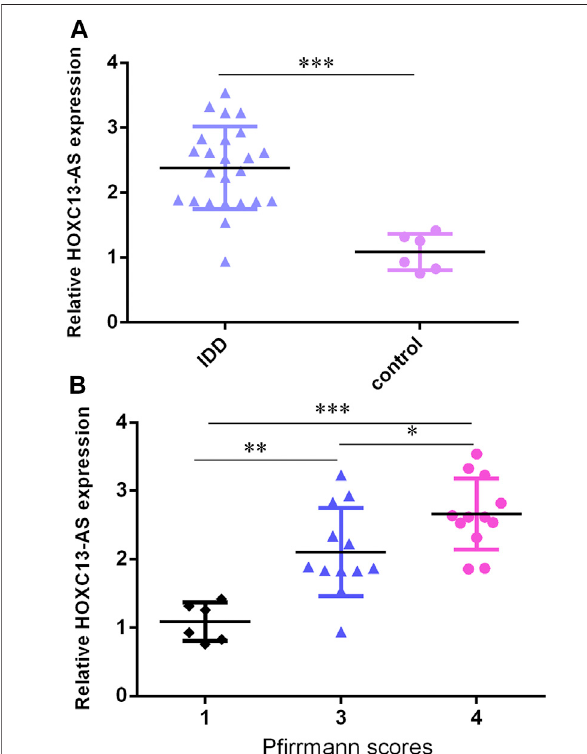
FIGURE 2 | HOXC13-AS was upregulated in IDD specimens. (A) HOXC13-AS was overexpressed in IDD specimens compared to control specimens by RT-qPCR. (B) Higher expression of HOXC13-AS was correlated with high P fi rrmann scores. * p < 0.05, ** p < 0.01, and *** p < 0.001.